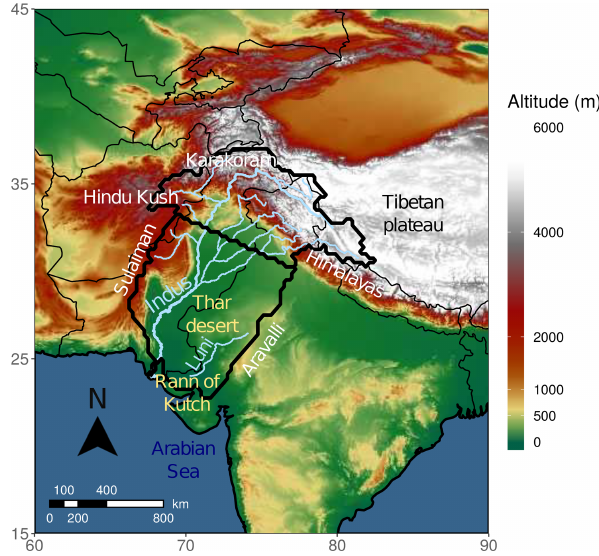
Figure 1. Relief and topographical features in and around the area investigated. The thick outer black contour represents the watershed on the Indus and Luni rivers. This area is split to form the two study areas: the upper Indus to the north, and the lower Indus to the